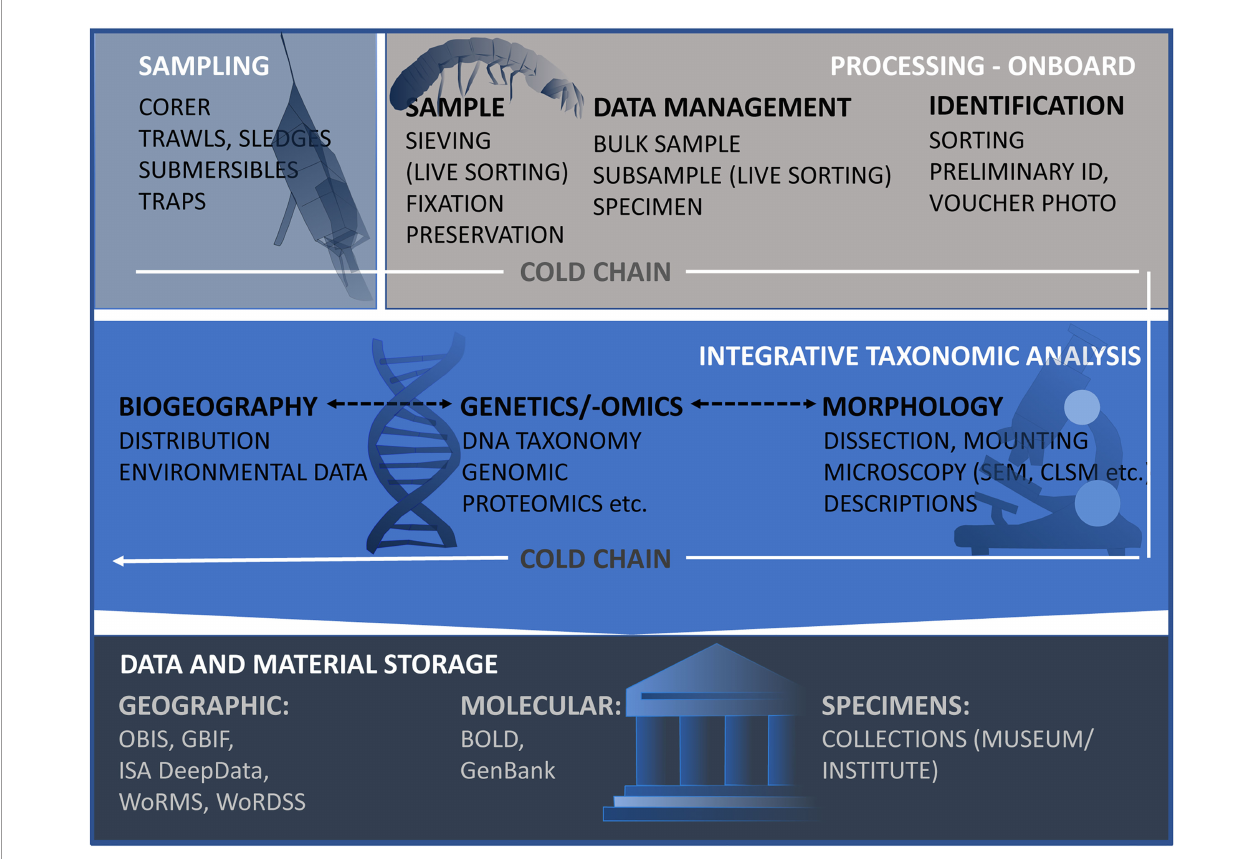
FIGURE 2 | Work fl ow to illustrate all steps that are required for the taxonomic investigation of the deep-sea peracarid fauna under the cold chain regime (Riehl et al., 2014) - from sampling, morphological taxonomic investigation, molecular and biogeographic analysis to the fi nal storage of samples and data. Links to: OBIS, Ocean Biogeographic Information System 1 ; GBIF, Global Biodiversity Information Facility 2 ; DeepData, Deep Seabed and Ocean Database of the International Seabed Authority 3 ; WoRMS, World Register of Marine Species 4 ; WoRDSS, World Register of Deep-Sea Species 5 ; BoLD, Barcode of Life Data System 6 ; and Genbank 7